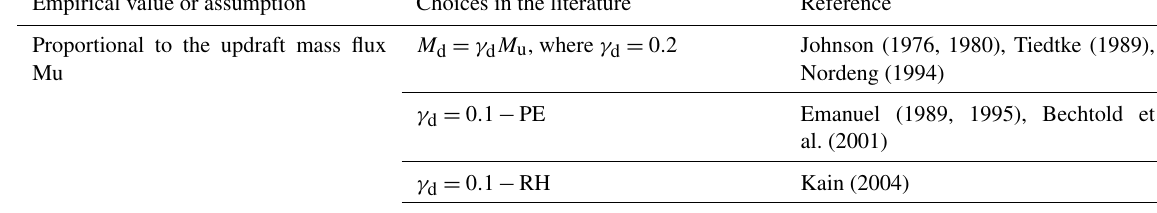
Function of updraft mass flux Mu and re-evaporation of convective conden- sate Function of updraft mass flux M u , height z , and maximum downdraft en- trainment rate ε d max